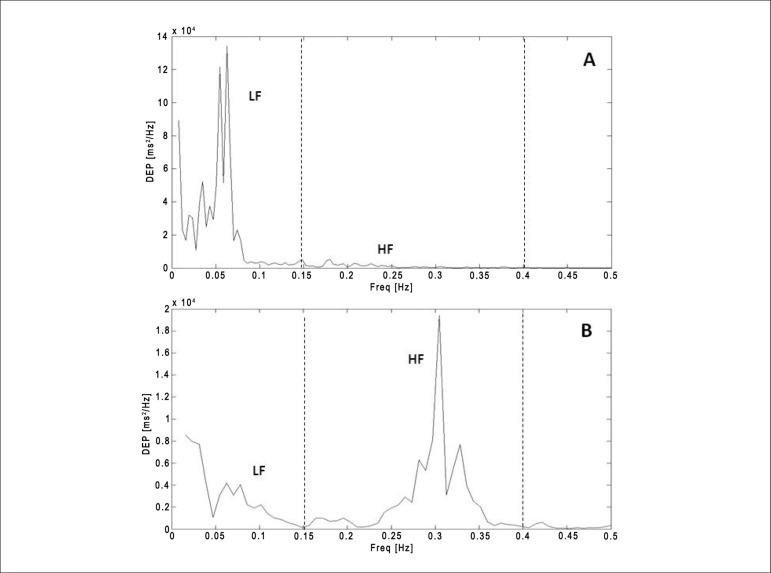
Power spectrum representation of a morbidly obese volunteer (A = 37 years old,
172.6 kg of body weight, 1.78 m of height and body mass index 54.6
kg/m2) and a nonobese volunteer (B = 40 years old, 73.4 kg of body
weight, 1.73 m of height and body mass index 24.5 kg/m2).